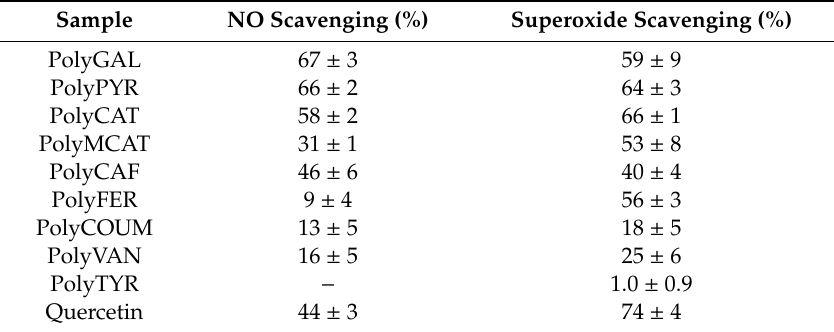
Table 3. Radical-scavenging properties of the acid-treated phenolic polymers 1